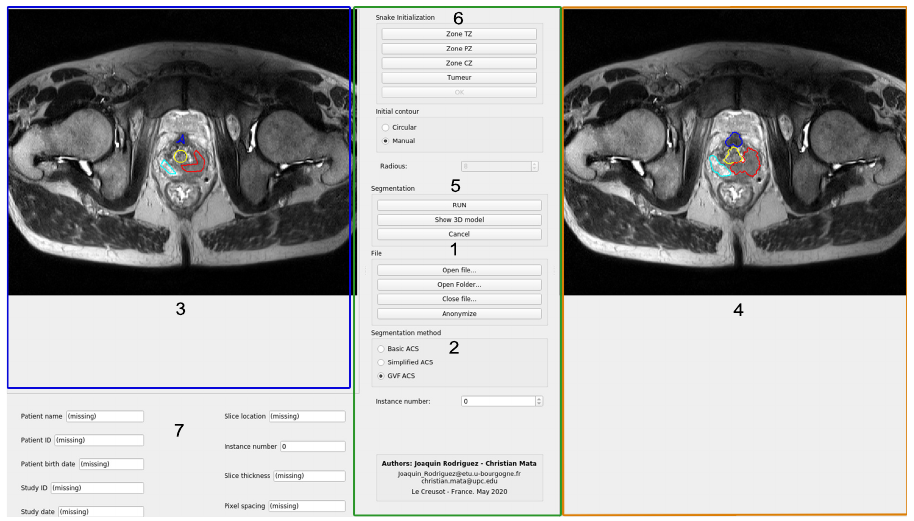
Figure 3. GUI interface of the developed active contour segmentation tool using a prostate MR